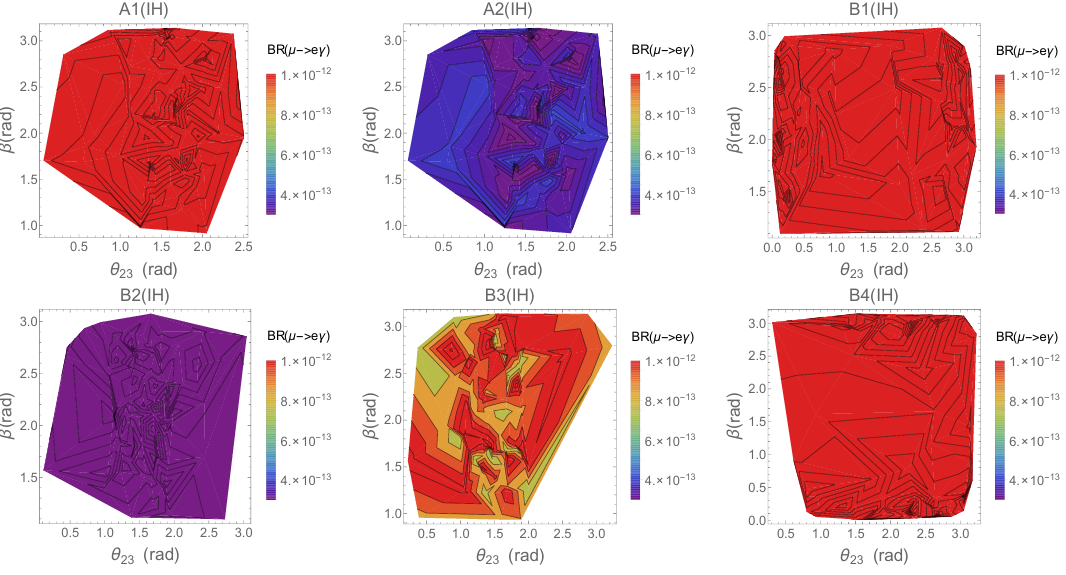
Figure 21 . Atmospheric mixing angle, (cid:18) 23 Vs Majorana phase (cid:11) (for IH) with BR for (cid:22) ! e (cid:13) as the contour where 4 : 2 (cid:2) 10 (cid:0) 13 is the upperlimit for BR given by MEG experiment.